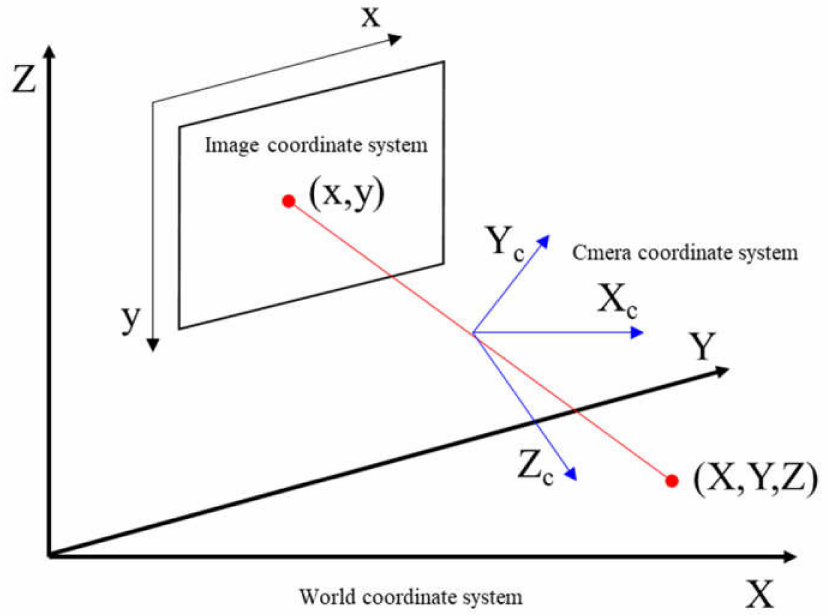
Figure 2. Conversion relationship between three-dimensional spatial coordinates and two-dimensional planar